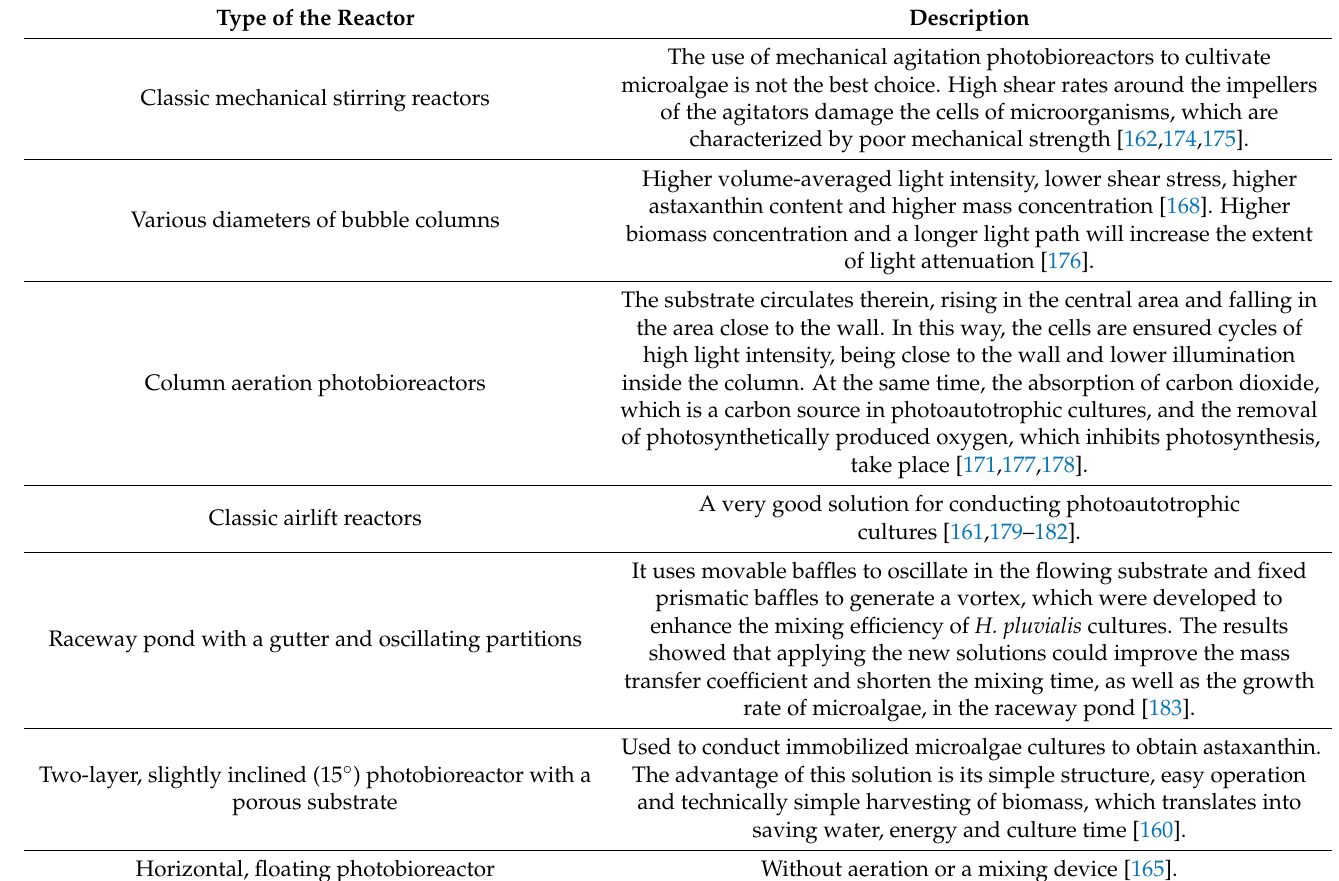
Table 11. Typical photobioreactors used in astaxanthin production on an industrial scale.